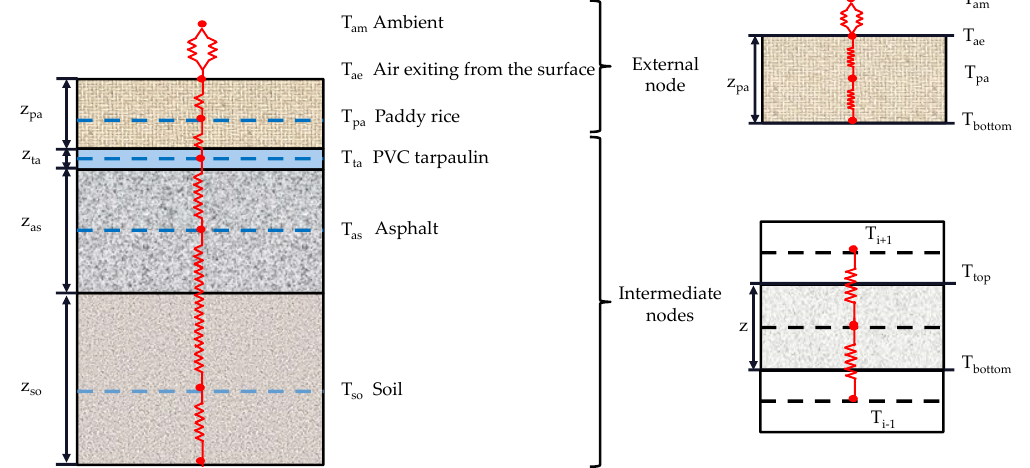
Figure 1. Thermal network of a one-dimensional model for the sun drying of paddy rice with layer thickness z and temperatures of ambient air, T am , air exiting from the surface, T a e , paddy rice, T pa , polyvinyl chloride (PVC) tarpaulin, T ta , asphalt, T as , and soil, T so .